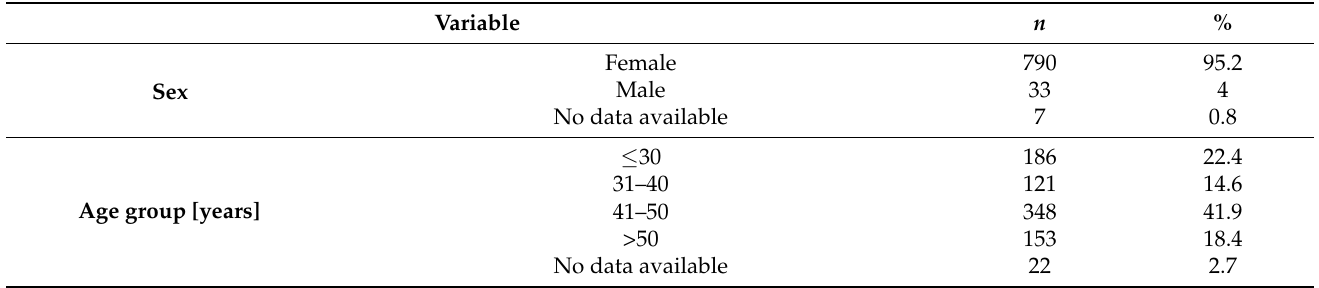
Table 1. Characterisation of the group under